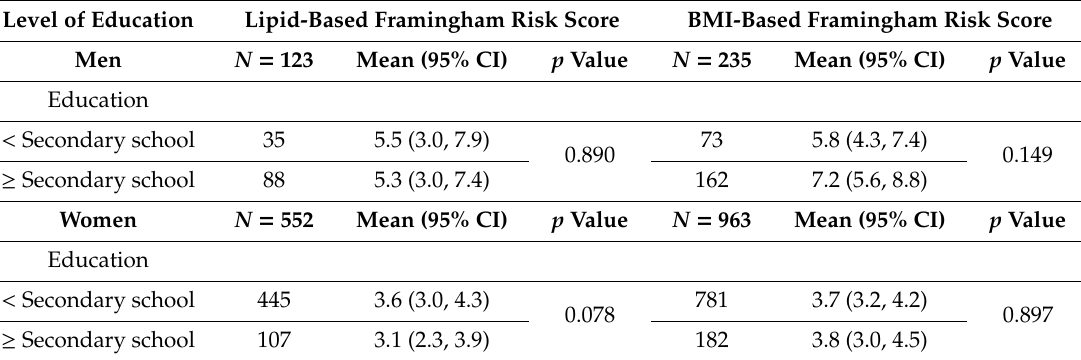
Table 5. Estimated Framingham risk score by education, age adjusted a